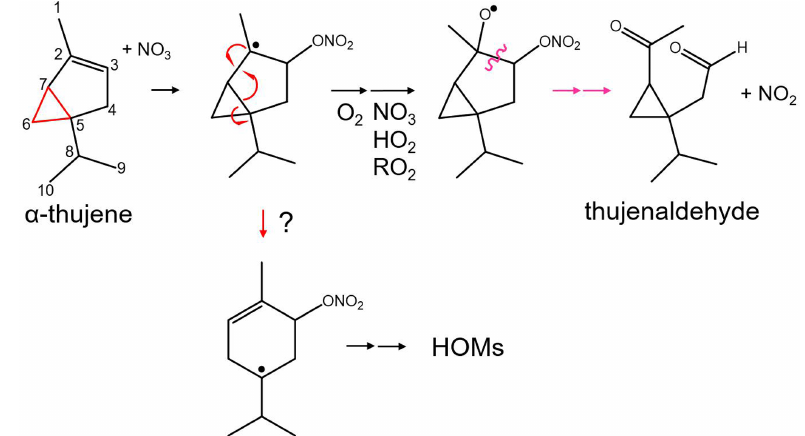
Figure 1. Scheme of the proposed α -thujene + NO 3 oxidation mechanism. Orange arrows indicate the formation of thujenaldehyde – a volatile product that is not expected to contribute to new particle formation. The downward arrow indicates a potential alkyl radical rear- rangement that leads to a product that can undergo additional oxidation to form highly oxygenated molecules